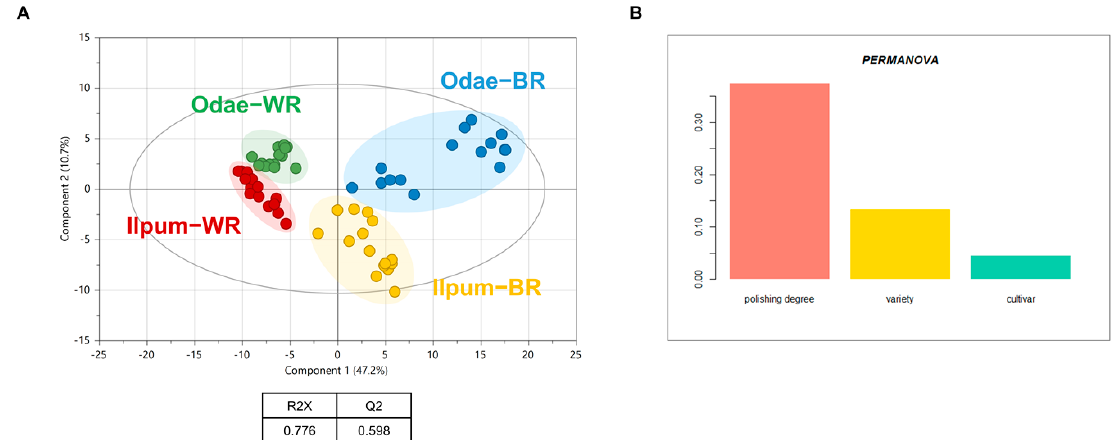
Figure 2. Metabolic phenotypes of the rice profiles using multivariate statistical analysis. ( A ) The score plot of the rice profiles based on principal component analysis (PCA). The variance is best explained by the t1 vector (component 1, 47.2%) which separated the profiles according to polishing degree (white vs. brown rice). The cultivar (Odae vs. Ilpum) were separated by the t2 vector (component 2, 10.7%). White rice (WR) and Brown rice (BR) indicate white rice and brown rice, respectively. ( B ) The explained levels of total variation in the metabolic profiles of rice explained by the major factors (polishing type, variety, and cultivation region) computed based on Permutational multivariate analysis of variance